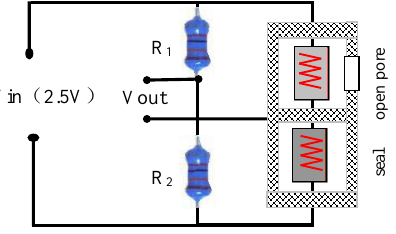
Figure 4. Detection circuit design, using a Wheatstone bridge.